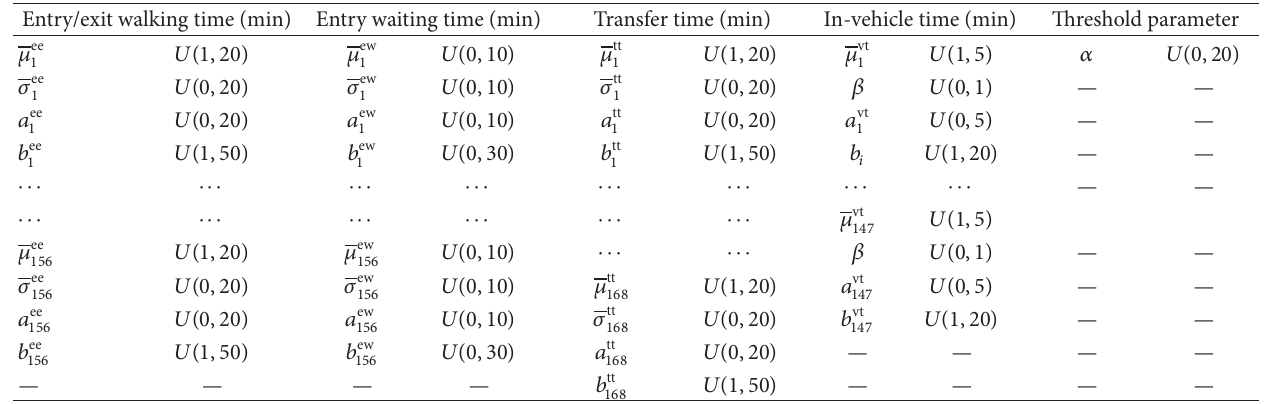
Table 1: The prior distributions of some parameters.